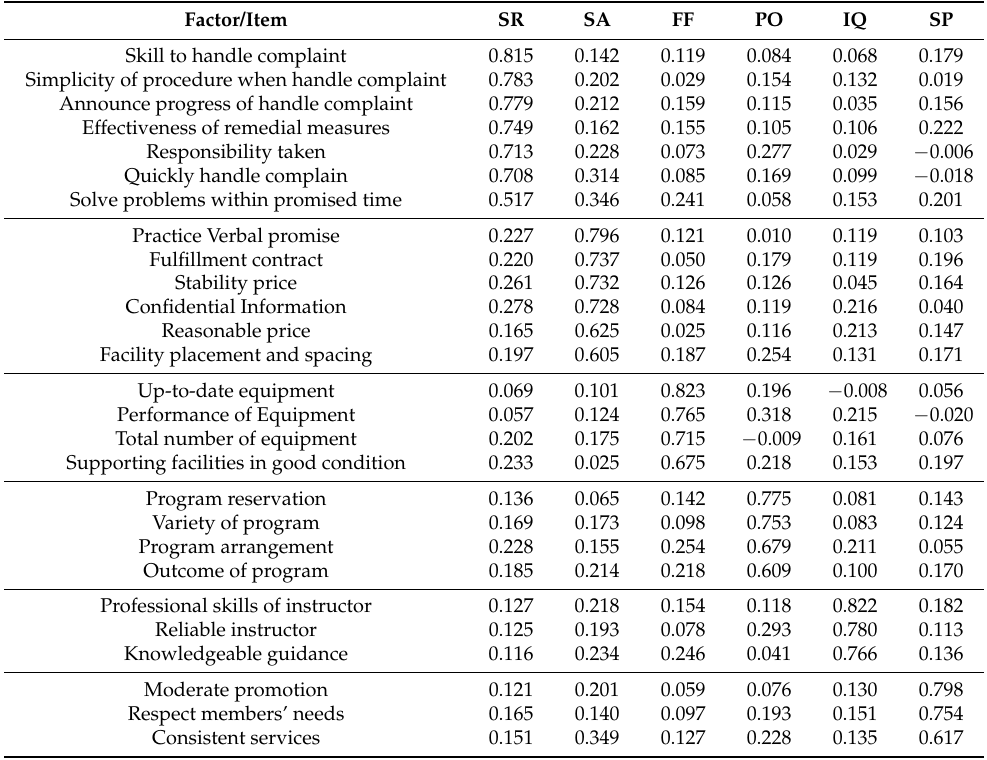
Table 6. Discrimination Validity of the Retained SFCS